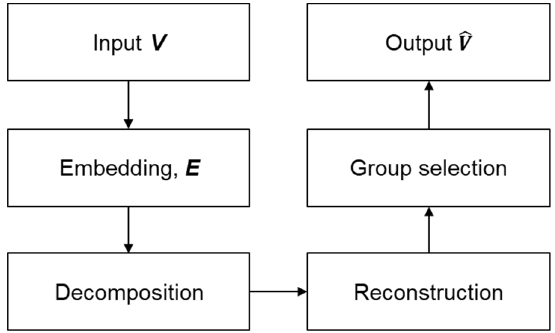
Figure 2. Block diagram of the multivariate singular spectral analysis (MSSA) algorithm.